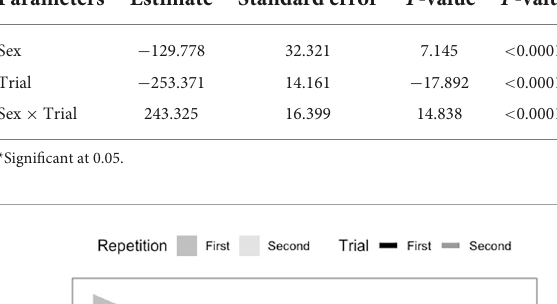
TABLE 2 Parameter estimated for the linear mixed model estimating the effect of sex, trial and the interaction between trial and vocal sex, on the time spent finding the roost by non-vocal bats.